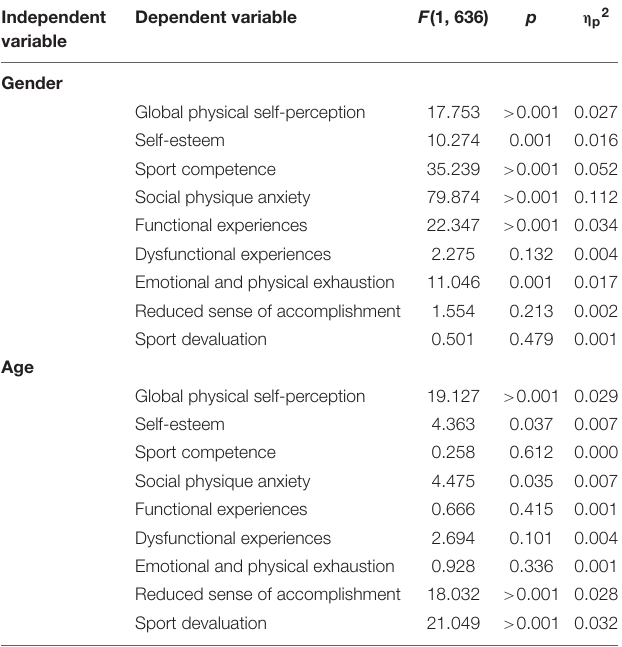
TABLE 2 | Gender and age univariate follow-up comparisons.